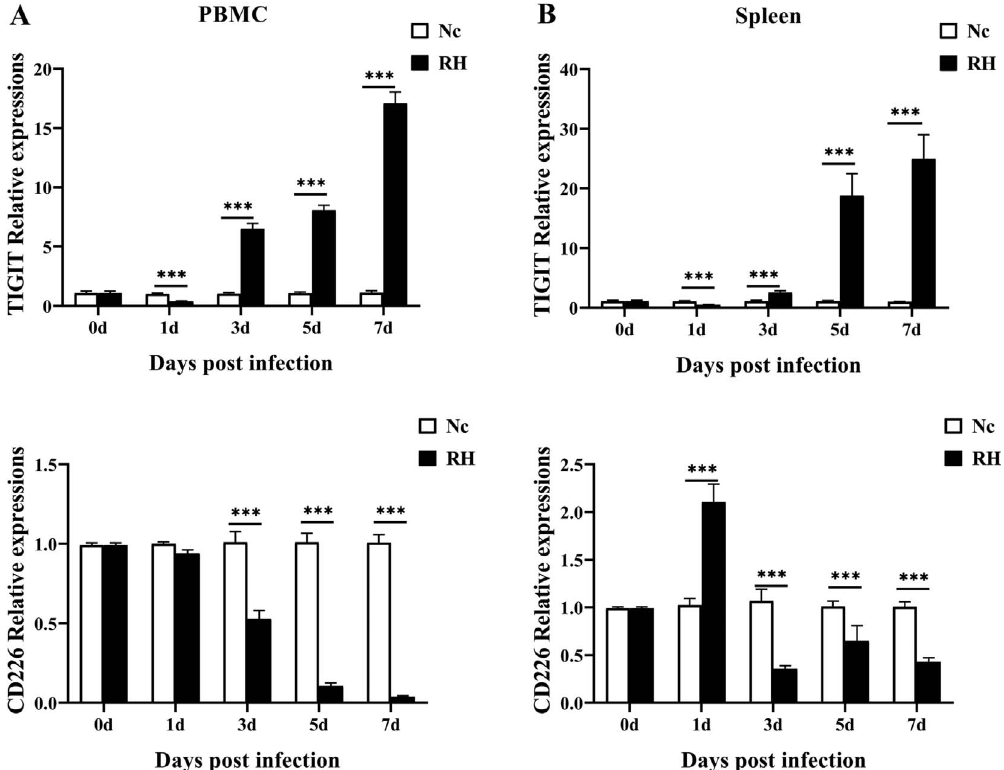
Figure 5. mRNA expression of TIGIT and CD226 in the PBMCs and spleens from mice infected with the T. gondii RH strain, as assessed by qRT-PCR. A: Data obtained from PBMCs. B: Data obtained from the spleen. Values are the means from triplicate measurements, with data denoting means ± SDs; three independent experiments were performed with fi ve mice per group. * p < 0.05, ** p < 0.01 and *** p < 0.001 (compared to the